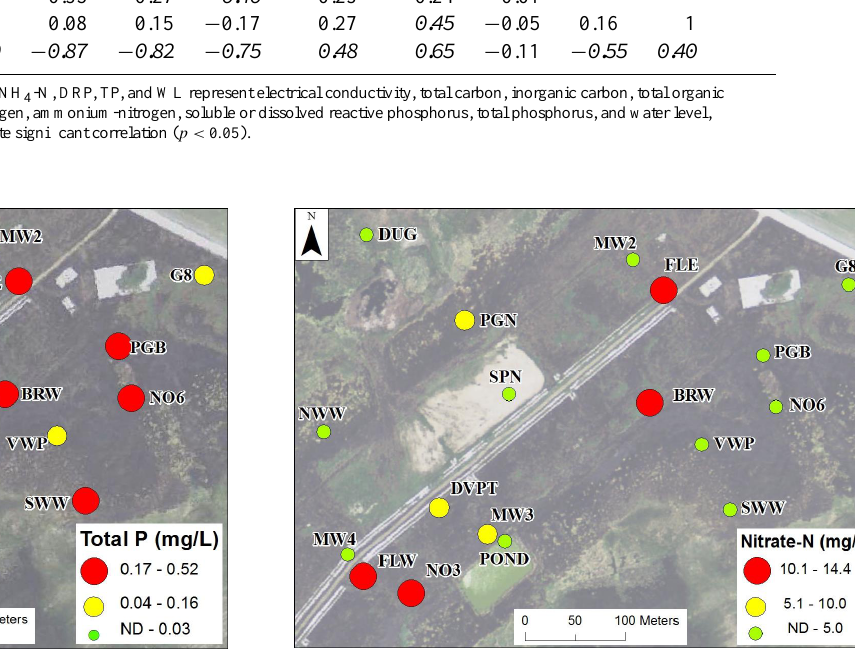
Figure 3. Total phosphorus (TP) concentrations (summer 2013). Fig. 3. Total phosphorus (TP) concentrations (summer 2013).